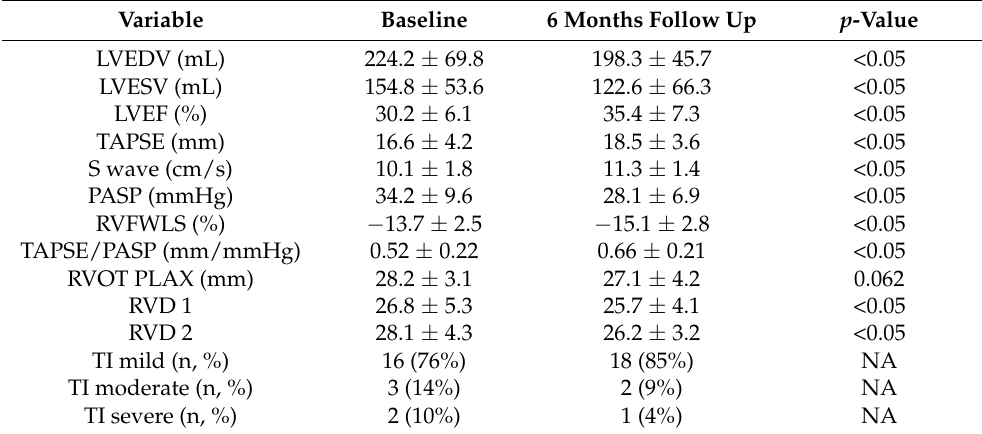
Table 3. Effects of CCM on LV and RV echocardiographic variables at six months follow up.